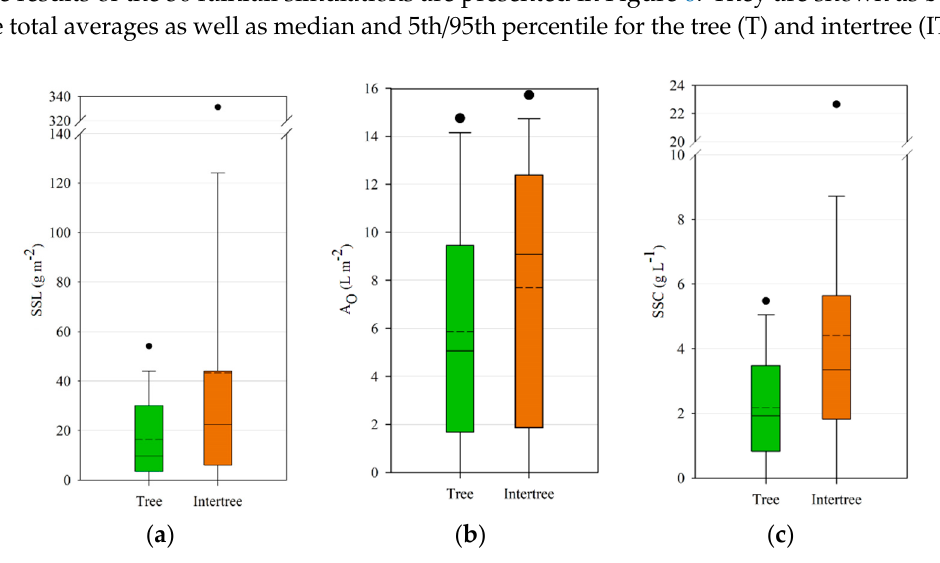
Figure 6. Total average of ( a ) suspended sediment load (SSL), ( b ) surface runoff (A O ), and ( c ) suspended sediment concentration (SSC) (short dash: mean line, solid line: median, dots: outliers). Results for the tree-covered areas (left box) and intertree areas (right box).